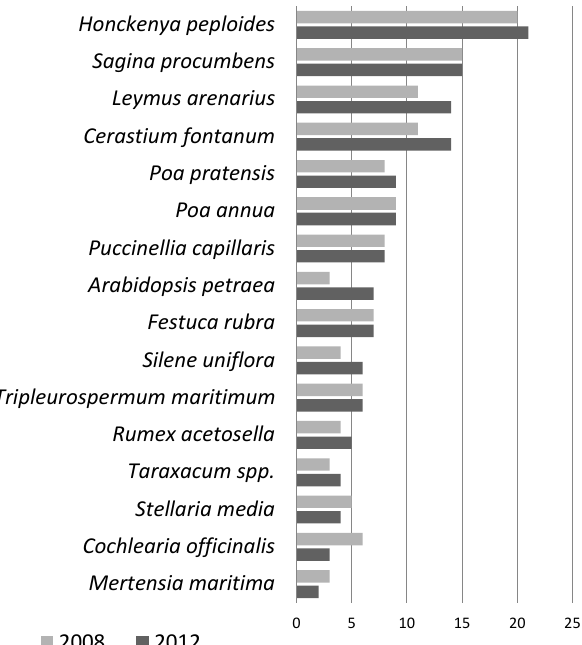
Figure 5. Relative frequency of vascular species in the 25 perma- nent plots on Surtsey in 2008 and 2012. Species occurring in ≥ 2 plots are